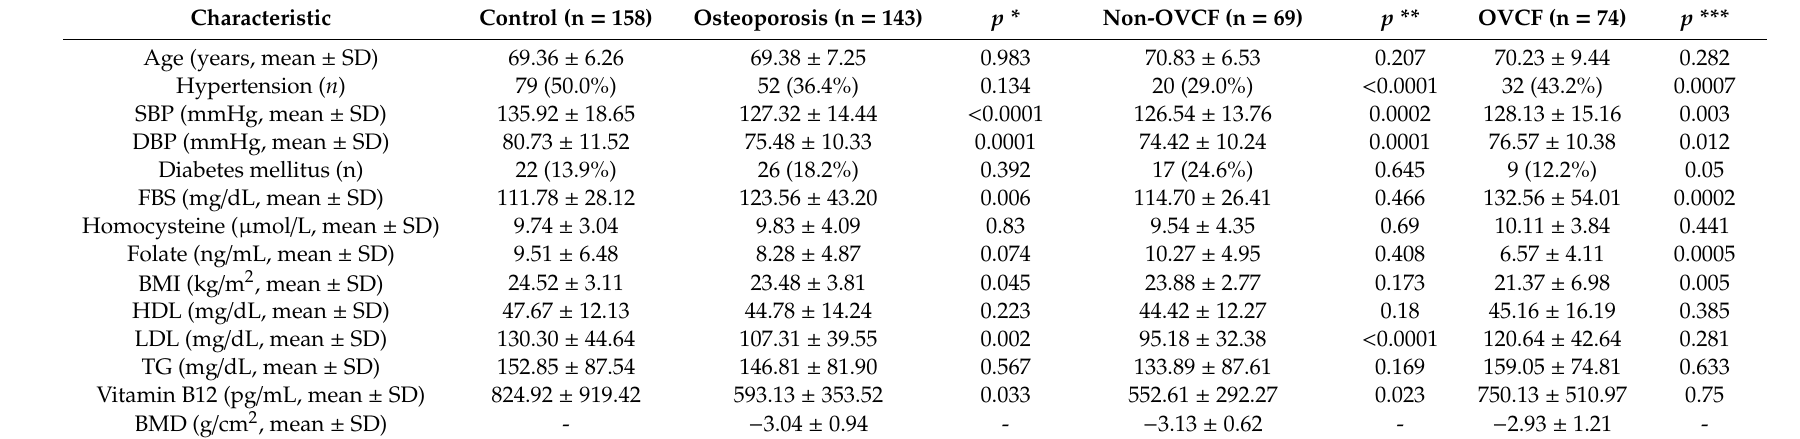
Table 1. Baseline characteristics of control and osteoporosis